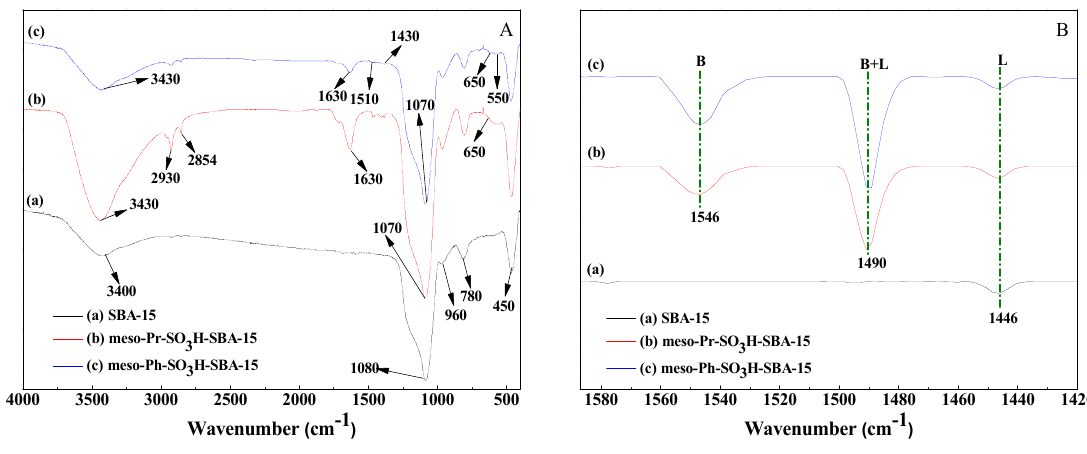
Figure 5. FT ‐ IR spectra ( A ) and Py ‐ FT ‐ IR spectra ( B ) of SBA ‐ 15 (a), meso ‐ Pr ‐ SO 3 H ‐ SBA ‐ 15 (b) and Figure 5. FT-IR spectra ( A ) and Py-FT-IR spectra ( B ) of SBA-15 (a), meso-Pr-SO 3 H-SBA-15 (b) and meso ‐ Ph ‐ SO 3 H ‐ SBA ‐ 15 (c) samples. meso-Ph-SO 3 H-SBA-15 (c)